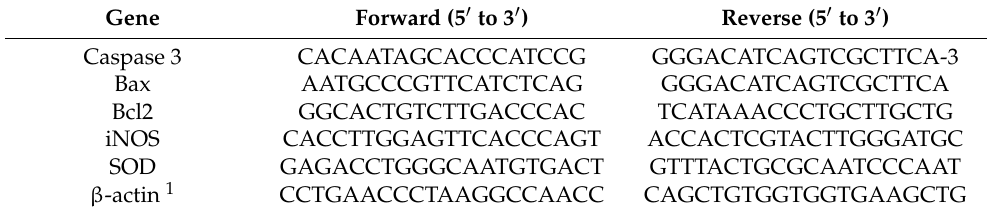
Table 1. Primer sets used in this